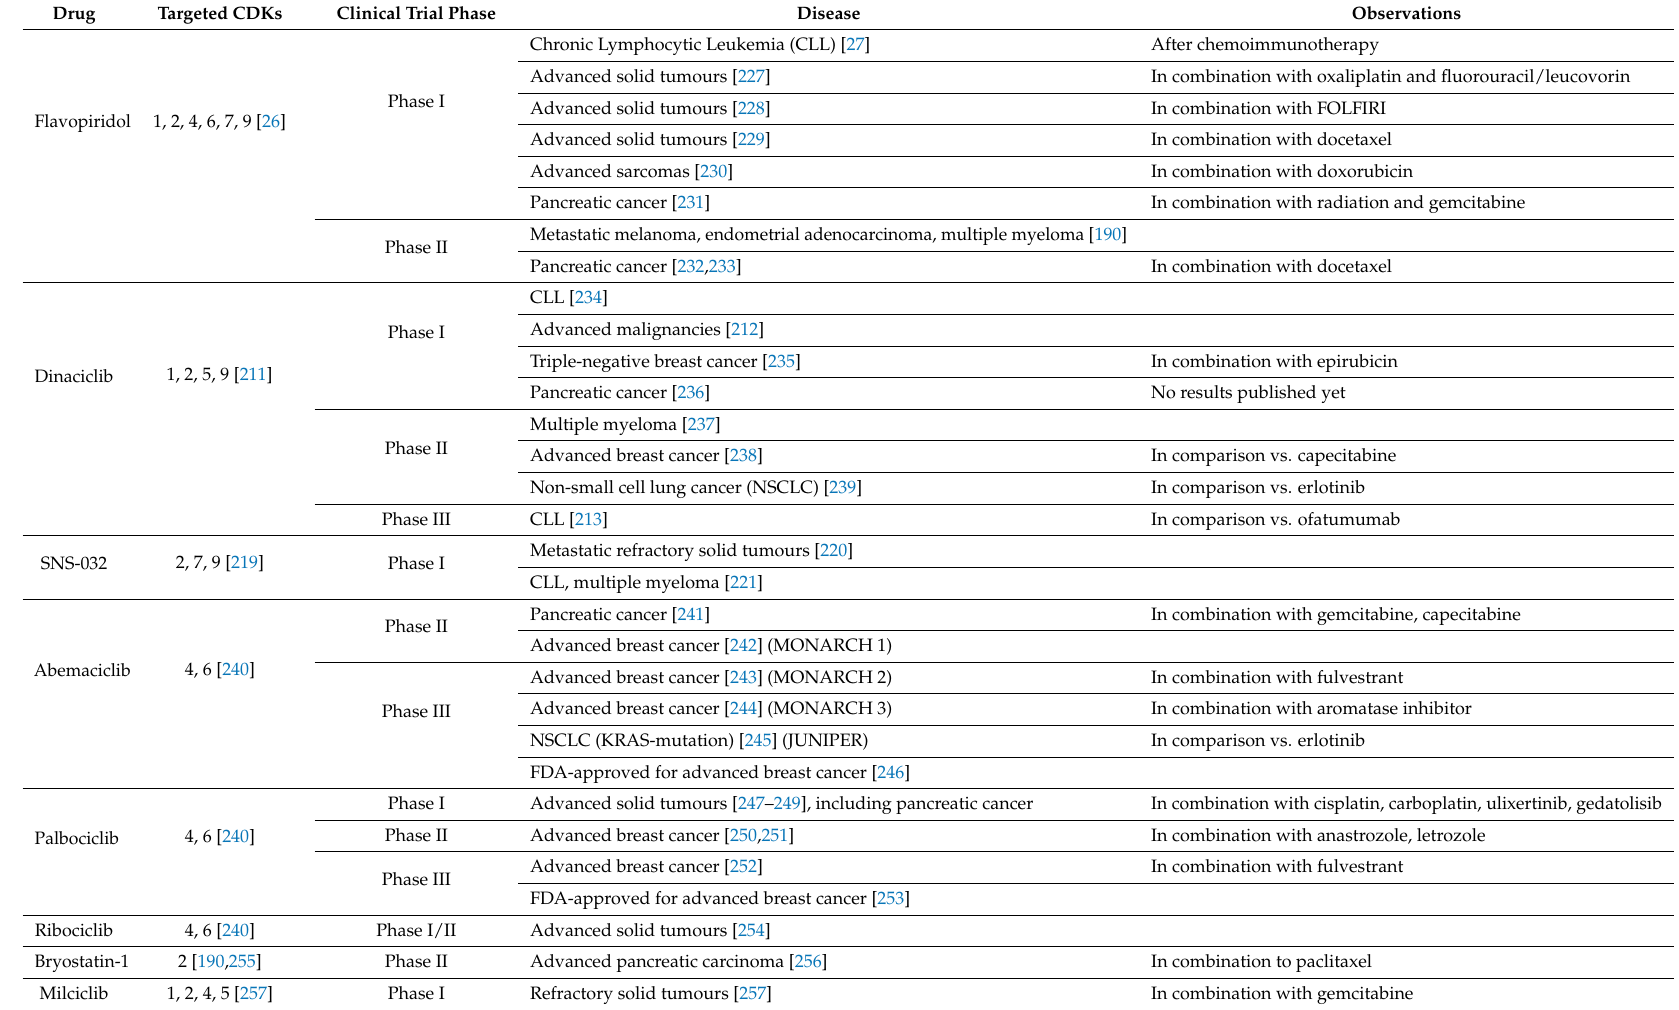
Table 2. CDK-specific inhibitors currently studied in clinical